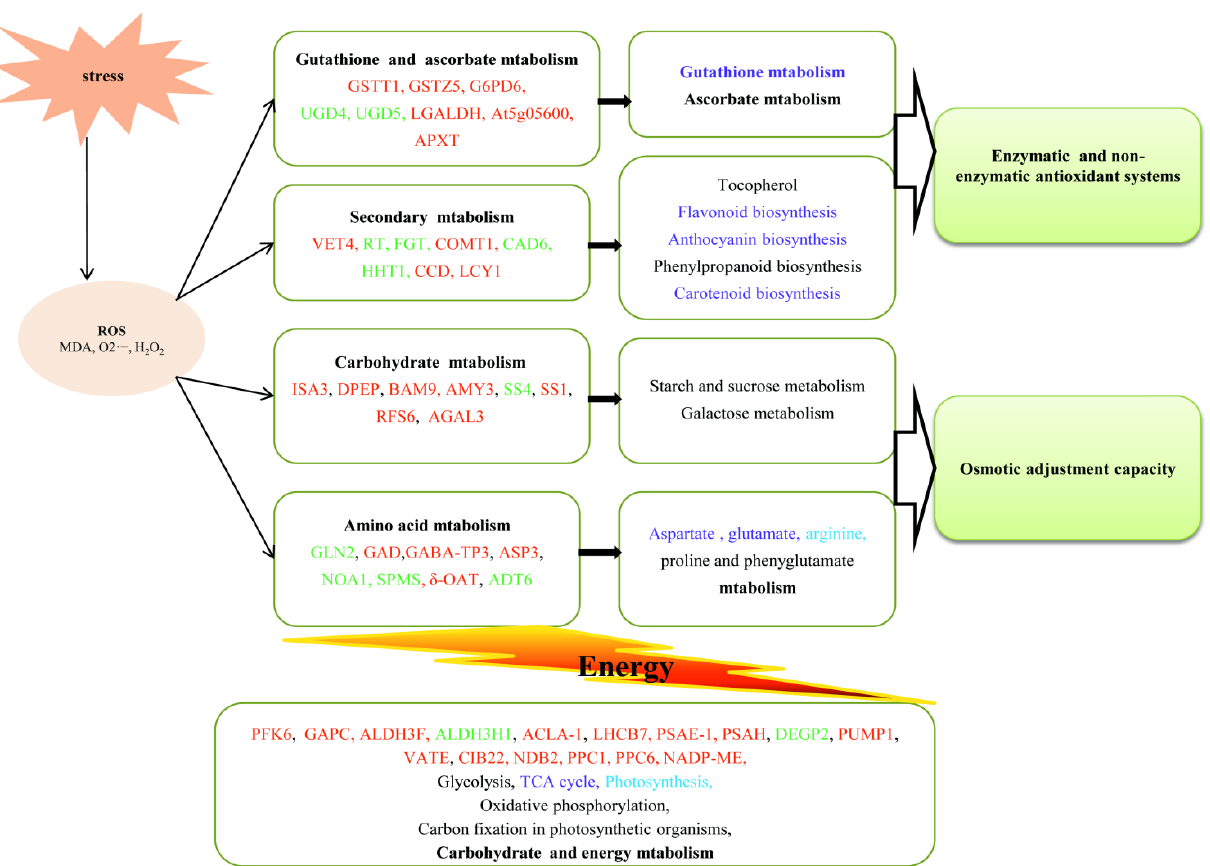
Figure 6. Model of pitaya responses to PEG-induced drought stress developed according to physiological and proteomic changes. Abbreviated enzyme names are listed in Table S6. Enzymes in green and red represent downregulated and upregulated proteins, respectively. Metabolic pathways in light blue and purple were mainly affected at 6 h and 3 days after initiating a drought-stress treatment, respectively.